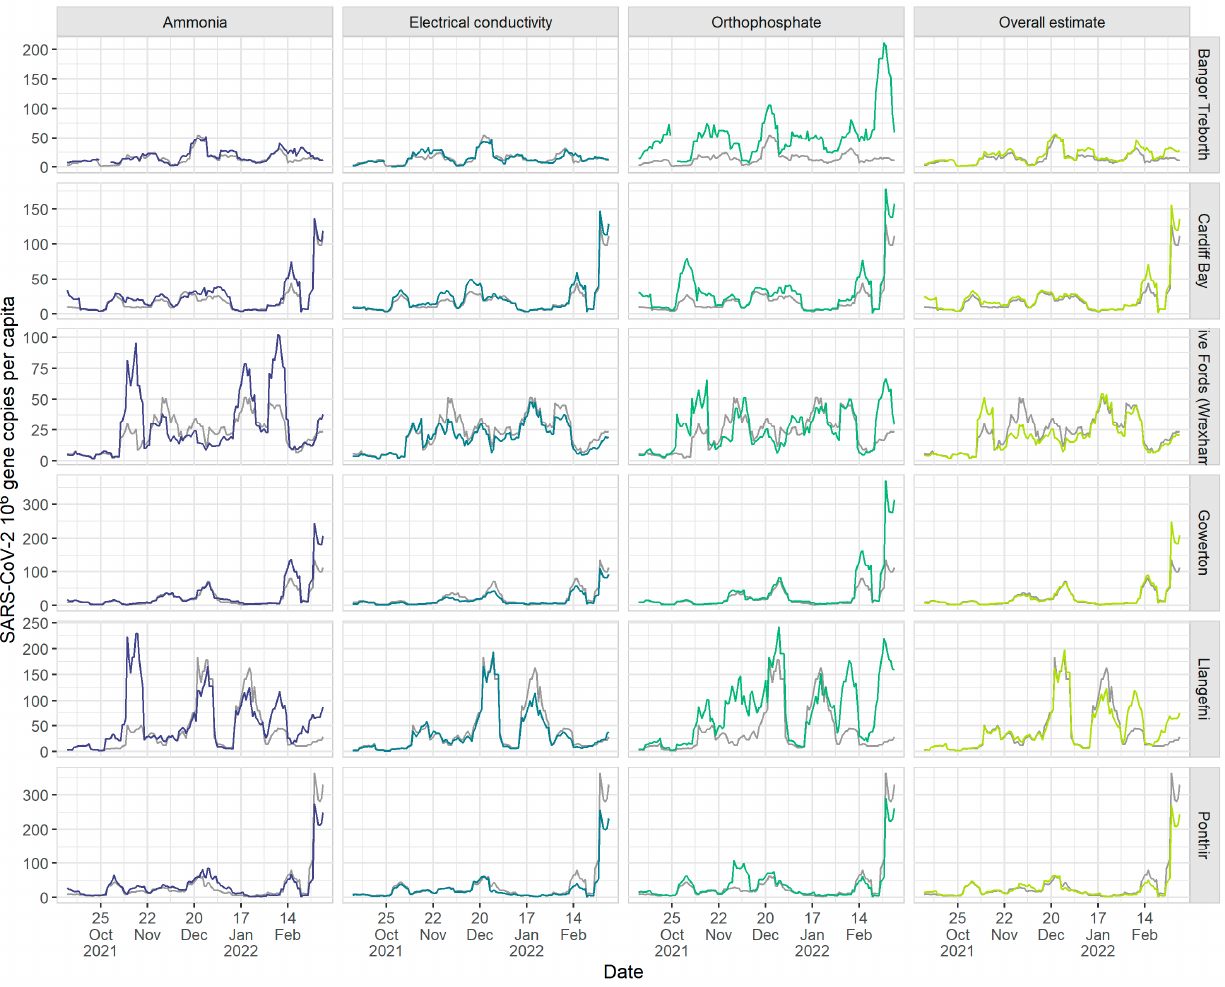
Figure 4. Time series for SARS-CoV-2 viral load from each marker estimate and the combined esti- mate (far right column) for six wastewater treatment sites in Wales. The figure shows the time series of the various estimates for SARS-CoV-2 viral load over a 21-week period up to 7 March 2022 at each site. Each marker is presented in its own colour as a 10-day, right-aligned rolling average. Im- posed on each plot is the viral load as calculated with the observed daily flow data, presented in grey.